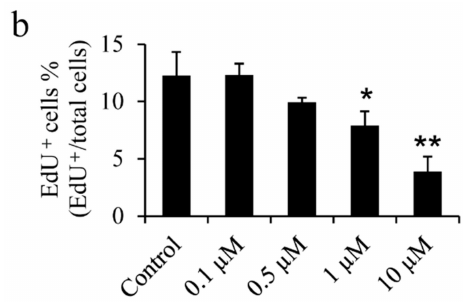
Figure 2. The effect of different concentrations of icariin on cell proliferation of OA–FLSs for 12 h. ( a ) The OA–FLSs were treated with 0.1, 0.5, 1 µ M and 10 µ M of Icariin. The proliferation of cells was measured by ethynyl deoxyuridine (EdU) assay, EdU staining (red) and Hoechst 33342 staining (blue), scar bar: 200 µ m. ( b ) The percentage of EdU + cells based on ( a ) statistical difference when compared to the control (* p < 0.05) and significant difference when compared to the control (** p < 0.01) (mean ± SD, n = 4).